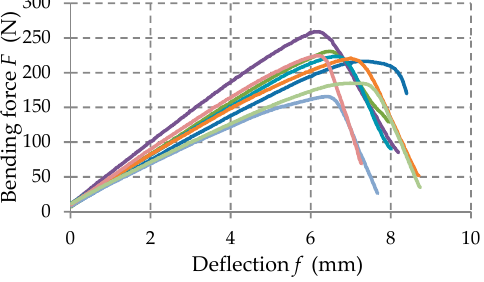
( ) δ− Figure 11. Force–deflection ( F − δ ) curves obtained in case of the specimens made of MAT 450 glass Figure 11. Force–deflection F curves obtained in case of the specimens made of MAT ( ) δ− Materials 2019 , 11 , x FOR PEER REVIEW 10 of 17 Figure 11. Force–deflection F curves obtained in case of the specimens made of MAT fibers/polyester resin. 450 glass fibers/polyester resin. 450 glass fibers/polyester resin.